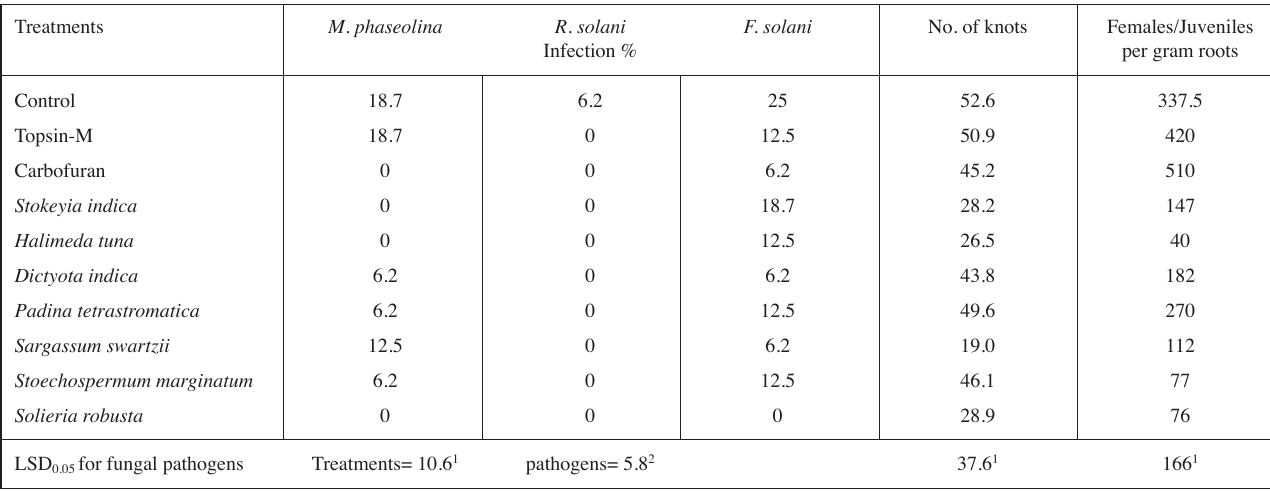
Tab. 1: Effect of seaweeds on the infection of root rotting fungi Macrophomina phaseolina, Rhizoctonia solani, Fusarium solani, F. oxysporum on soybean roots after 45 days of nematode inoculation in screen house experiment.